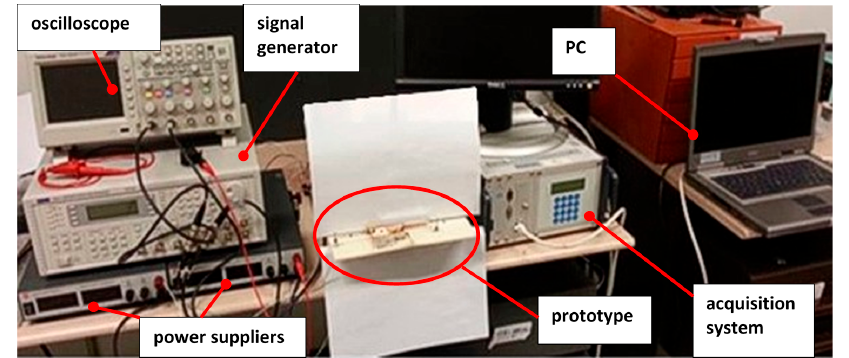
Figure 13. Experimental setup.